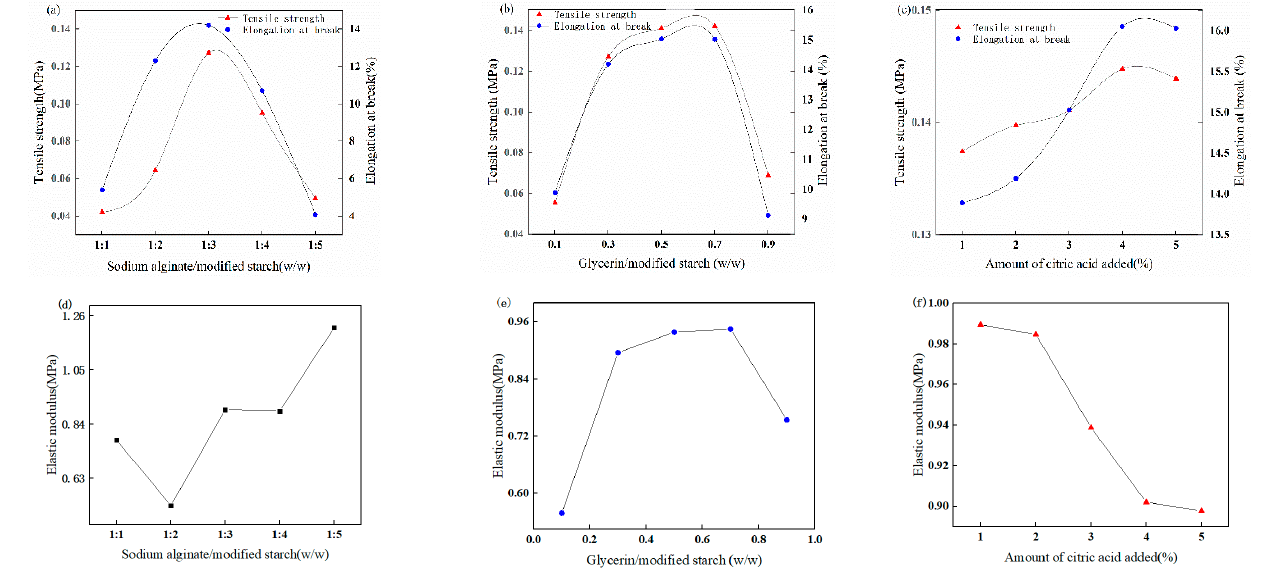
Figure 2. Effect of sodium alginate addition on the mechanical properties of the dry film ( a ), effect of glycerol addition on dry film mechanical properties ( b ), effect of citric acid addition on the mechanical properties of the dry film ( c ). Effect of sodium alginate addition on the elastic modulus of the dry film ( d ), effect of glycerol addition on dry film elastic modulus ( e ), effect of citric acid addition on the elastic modulus of the dry film ( f ).